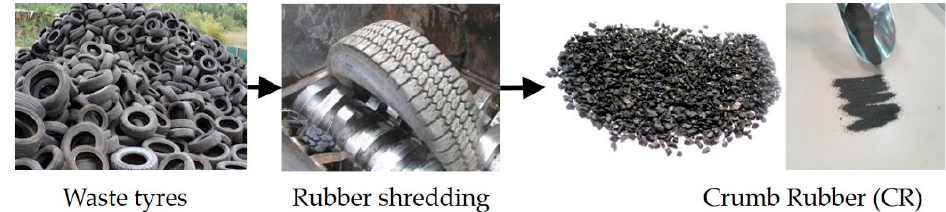
Figure 3. The utilized crumb rubber material.